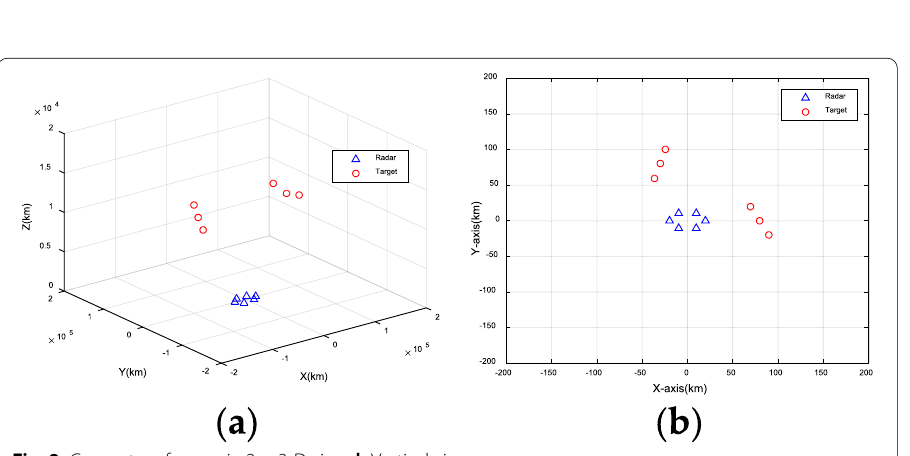
Fig. 9 Geometry of scenario 2. a 3-D view. b Vertical